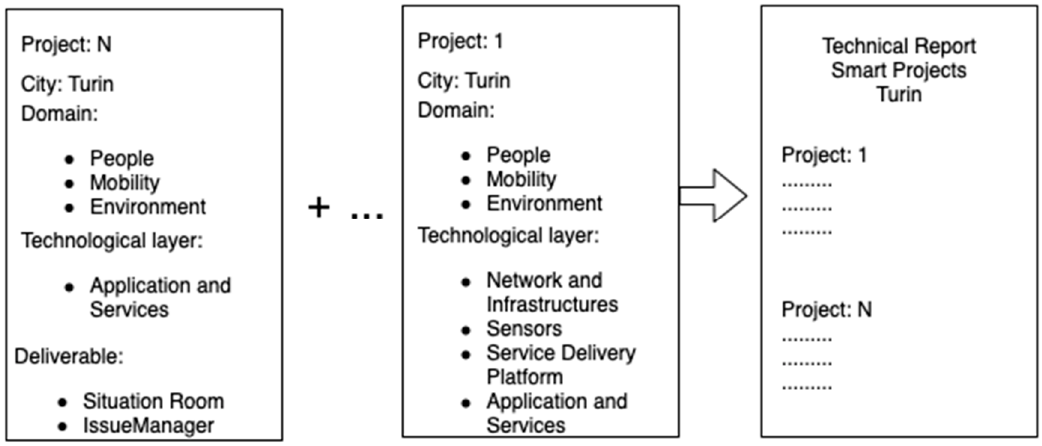
Figure 11. Technical report smart projects.